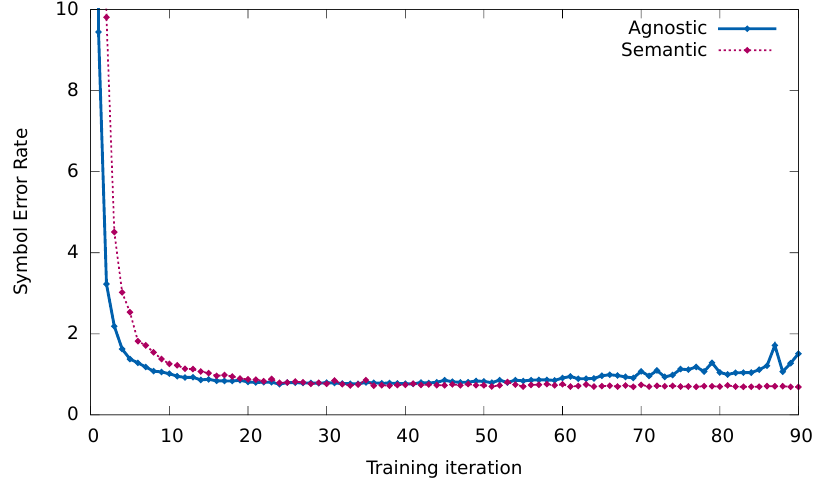
Figure 5. Symbol Error Rate over validation partition with respect to the training epoch.